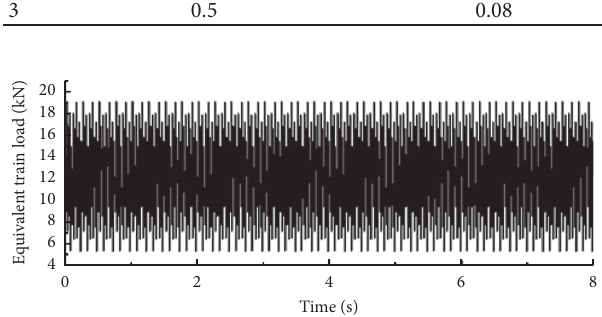
Figure 11: Vertical load induced by a train running at 242